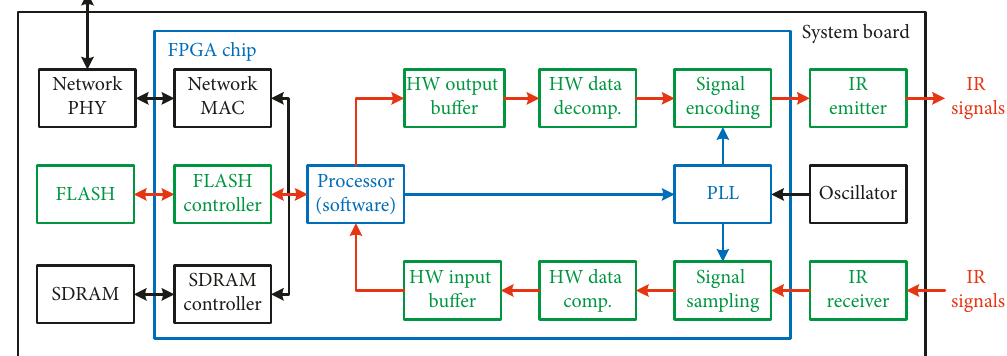
Figure 8: Implemented system architecture.